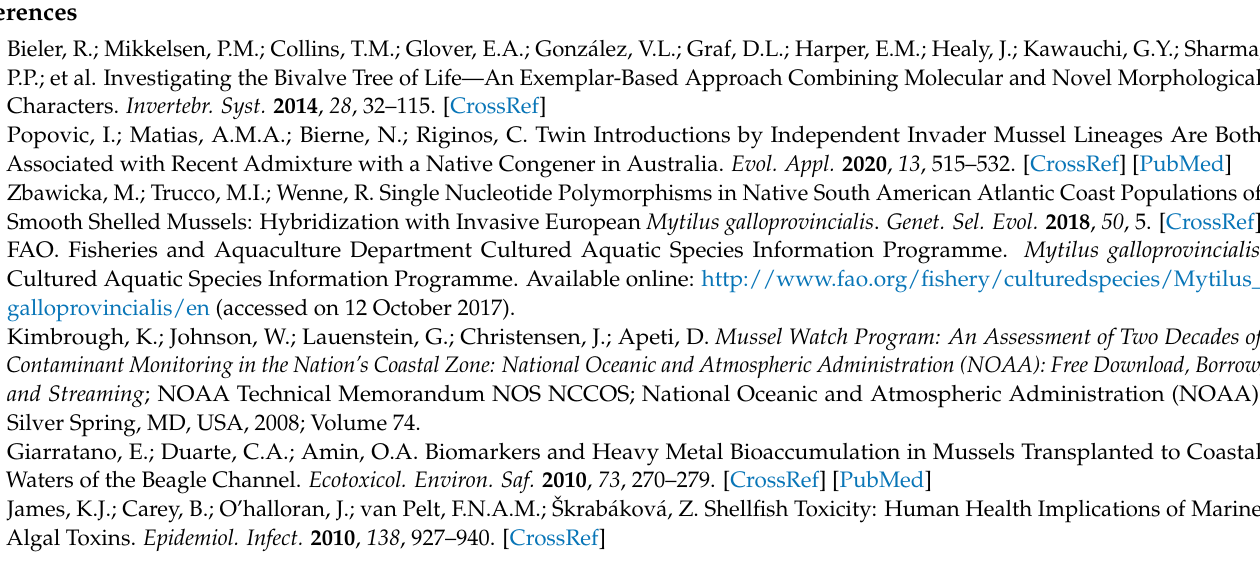
Figure S8: summary of the AlphaFold prediction scores obtained for representative members of the different mCRP-I sequence groups. Supplementary Materials Note S1: technical notes about the phased Mytilus edulis genome